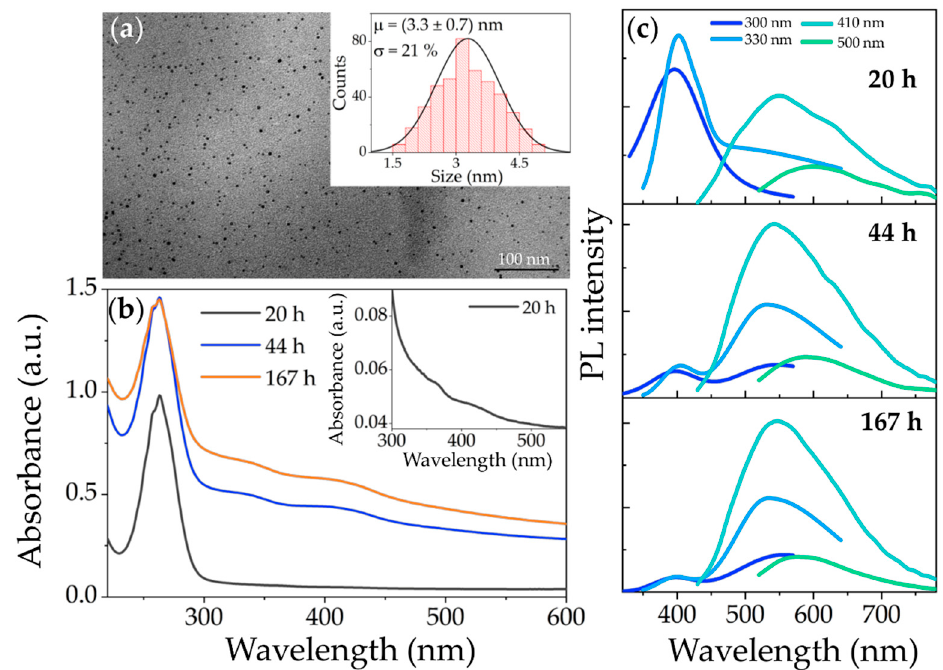
Figure 1. ( a ) TEM micrograph and size distribution (inset) of O-CDs synthesized at RT. The scale bar is 100 nm; ( b ) UV-Vis absorption spectra of a representative sample (CPC aqueous solution after addition of 90 mM NaOH) at increasing reaction times. For sake of clarity, the region above 300 nm of the spectrum recorded at 20 h is shown with a higher magnification in the inset; ( c ) PL spectra at different excitation wavelengths recorded for the samples in ( b ).